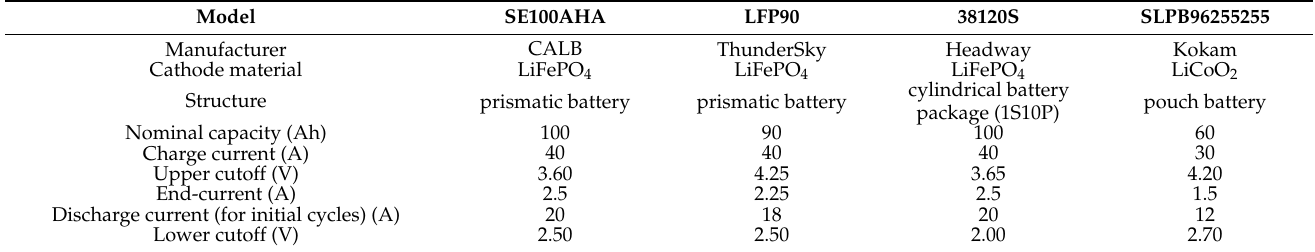
Table 1. Characteristics of investigated commercial automotive-grade lithium-ion